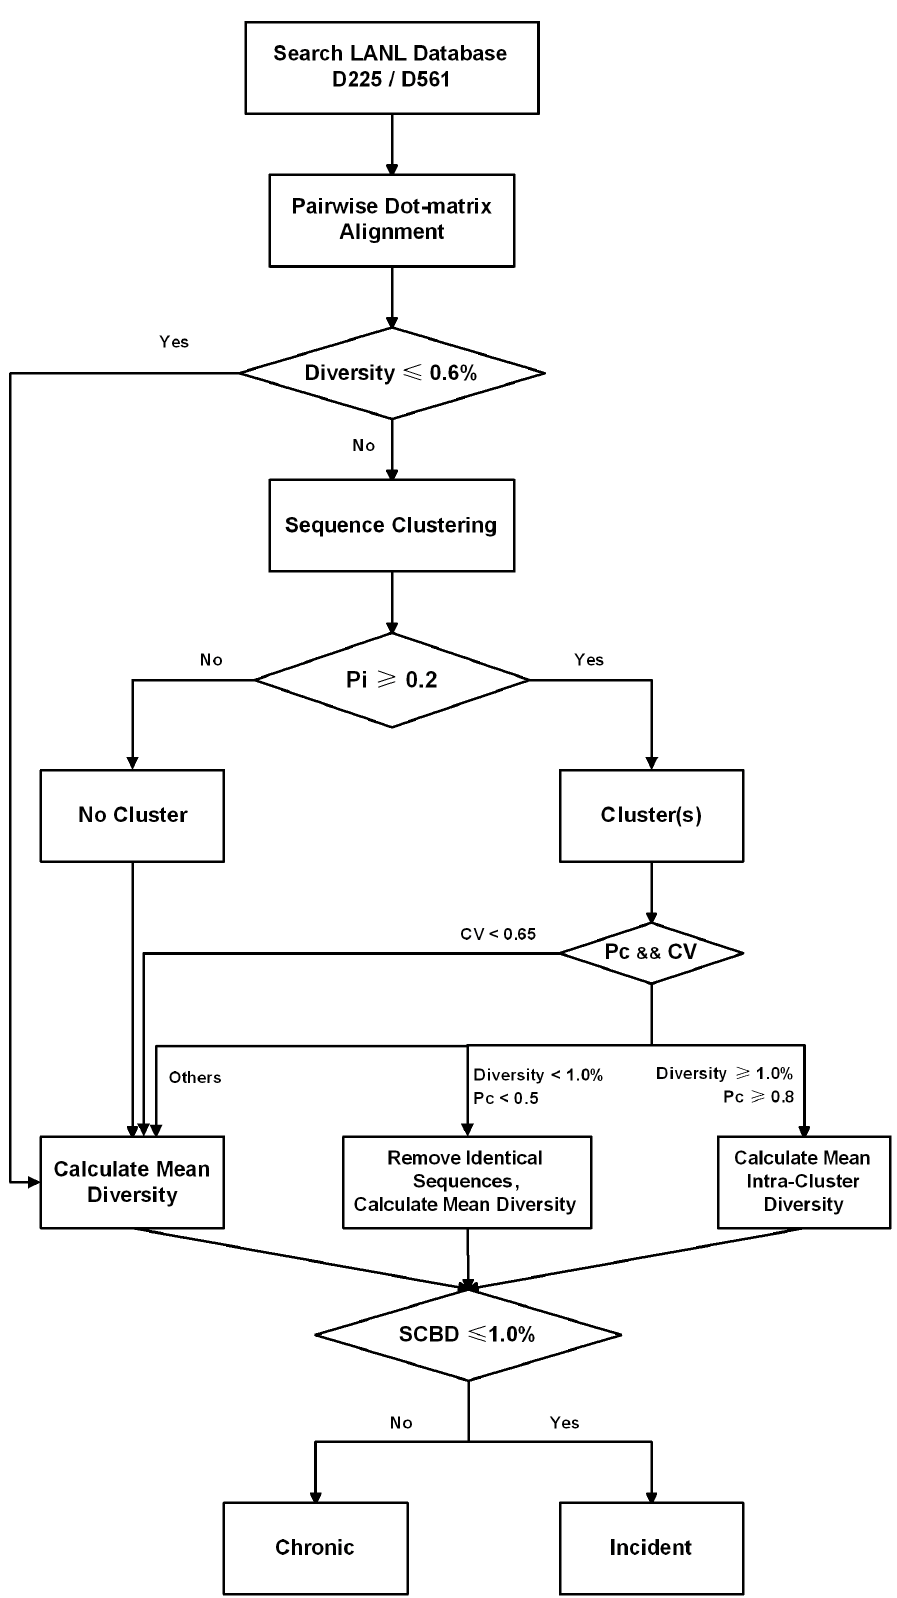
Figure 1. Flowchart for identifying incident from chronic HIV-1 infections using the sequence clustering-based diversity (SCBD) assay.